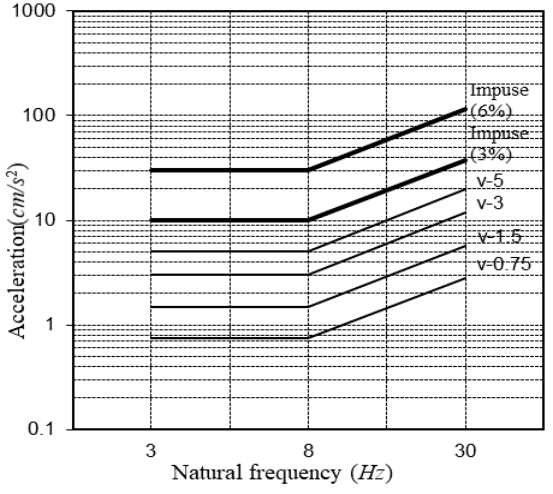
Figure 4. Japanese guidelines [11].